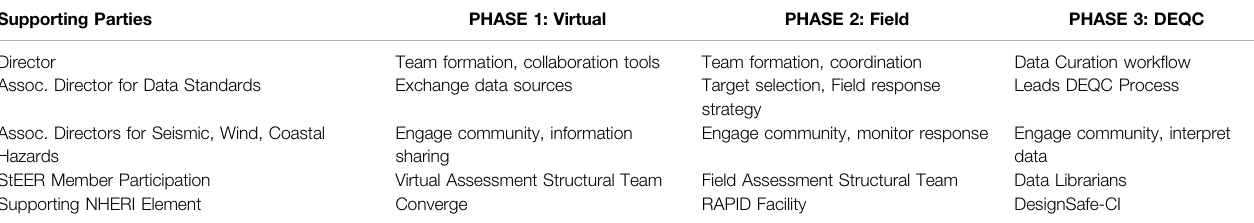
TABLE 2 | Organizational structure and roles in event response phases.